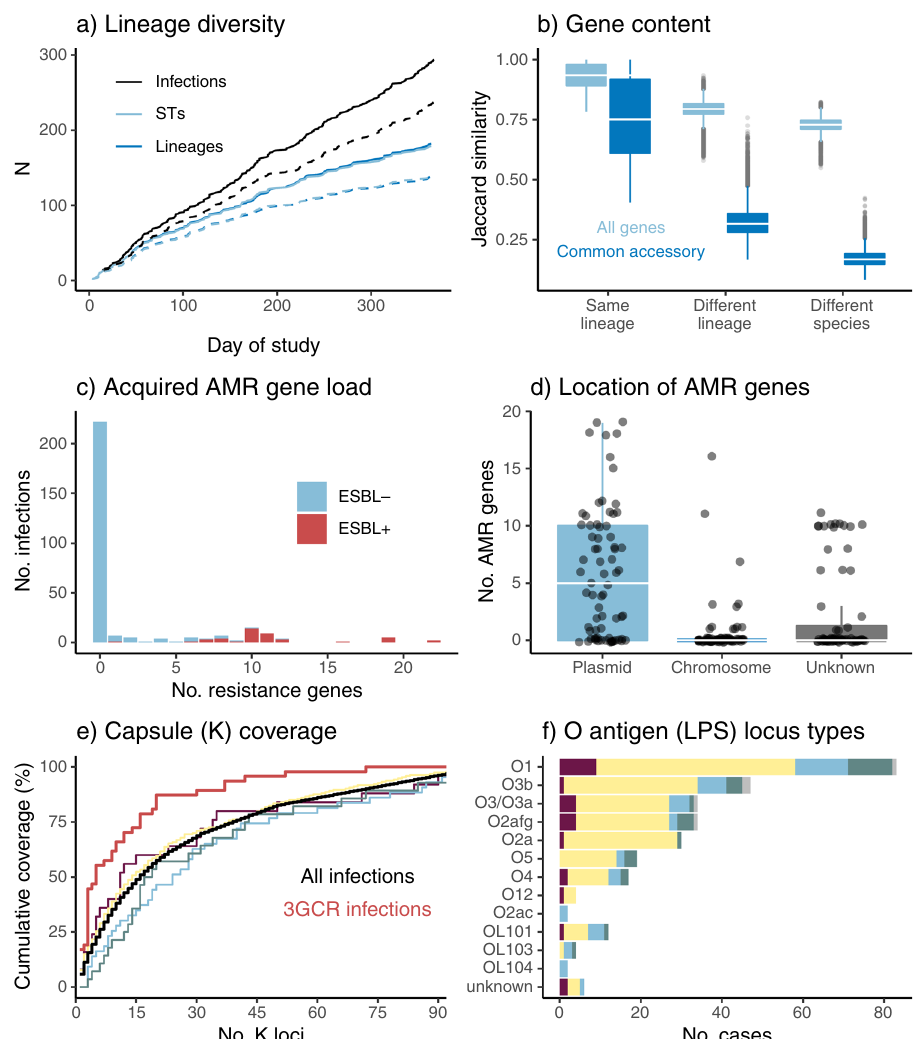
Fig. 3 Genomic diversity of clinical isolates identi fi ed as K. pneumoniae in the hospital microbiological diagnostic laboratory (one per infection episode, n = 294). a Accumulation of unique infection episodes (total 294 in 289 patients), lineages or sequence types (STs) over the study period. Solid lines = all K. pneumoniae species complex (KpSC); dashed lines = K. pneumoniae only (total n = 238). b Distribution of pairwise gene content Jaccard similarity between genomes, calculated using either all genes (including n = 3095 core genes present in all strains), or the n = 4,001 common accessory genes (each present in 5 – 95% of genomes sequenced). Boxplots elements are: center line, median; box limits, upper and lower quartiles; whiskers, 1.5x interquartile range; points, outliers. c Distribution of the number of acquired antimicrobial resistance (AMR) genes per genome, strati fi ed by detection of an extended spectrum beta-lactamase (ESBL) gene. d Number of AMR genes per genome that were attributed to plasmid- or chromosome-derived contigs using Kraken. Counts in each category are given for each of the n = 294 genomes. Boxplots elements are: center line, median; box limits, upper and lower quartiles; whiskers, 1.5x interquartile range; points, outliers. e Theoretical coverage of infections (y-axis) by vaccines targeting capsular antigens encoded by increasing numbers of K loci (x-axis, K loci ordered from most to least common in this data set as shown in Supplementary Table 1). Black line shows cumulative coverage of all unique infections ( n = 294); red line shows unique 3GCR infections ( n = 47); other lines show coverage of different infection types (maroon = disseminated, yellow = urine, blue = respiratory, green = wound, grey = other). f Frequency of O antigen (LPS) synthesis loci, strati fi ed by specimen type (coloured as per panel e